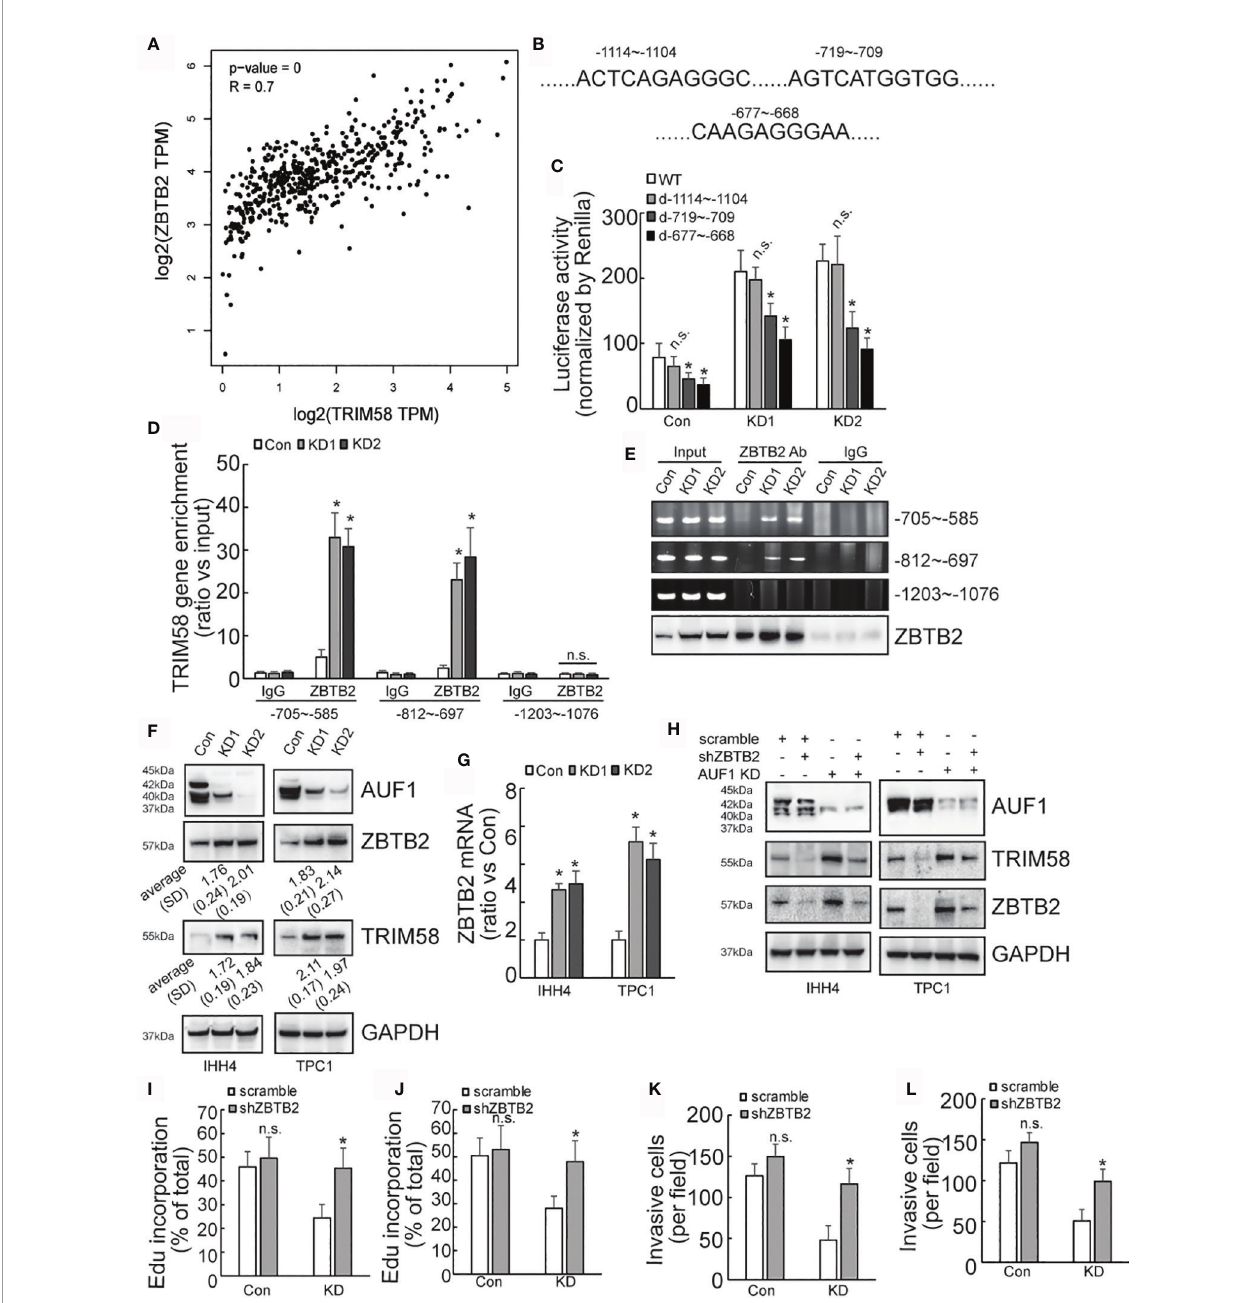
FIGURE 5 | AUF1-knockdown activates the expression of TRIM58 by increasing the expression of ZBTB2. (A) TRIM58 and ZBTB2 are co-expressed in thyroid cancer cells, and the two are positively correlated; (B) three ZBTB2 potential binding sites on the TRIM58 promoter; (C) the reporter gene activity of the mutants - 719~-709 and -677~-668 were reduced in all groups; (D) the results of ChIP experiments revealed that AUF1-knockdown increased ZBTB2 enrichment in the segments of -705~-585 and -812~-697 on the TRIM58 promoters; (E) the IP ef fi ciency by ZBTB2 was con fi rmed by western blot and agarose gel electrophoresis of PCR products of TRIM58 promoter fragments from input as well ChIP was performed. (F) AUF1-knockdown increased the expression of ZBTB2 and TRIM58; (G) ZBTB2 mRNA expression was evaluated using real time PCR; (H) Western blot was performed in IHH4 and TPC1 cells with indicated antibodies, and it was found that shZBTB2 suppressed the expression of TRIM58 in KD groups; (I) the proliferation ability of IHH4 cells was assessed using Edu incorporation in scramble- Con and shZBTB2-Con, scramble-KD, and shZBTB2-KD groups; (J) the proliferation ability of TPC1 cells was assessed using Edu incorporation; (K) Matrigel containing Transwell was used to analyze the invasion ability of indicated IHH4 cells and the numbers of invading cells were analyzed; (L) Matrigel containing Transwell was used to analyze the invasion ability of indicated TPC1 cells and the numbers of invading cells were analyzed. N.S., not signi fi cant; n = 3, *P <